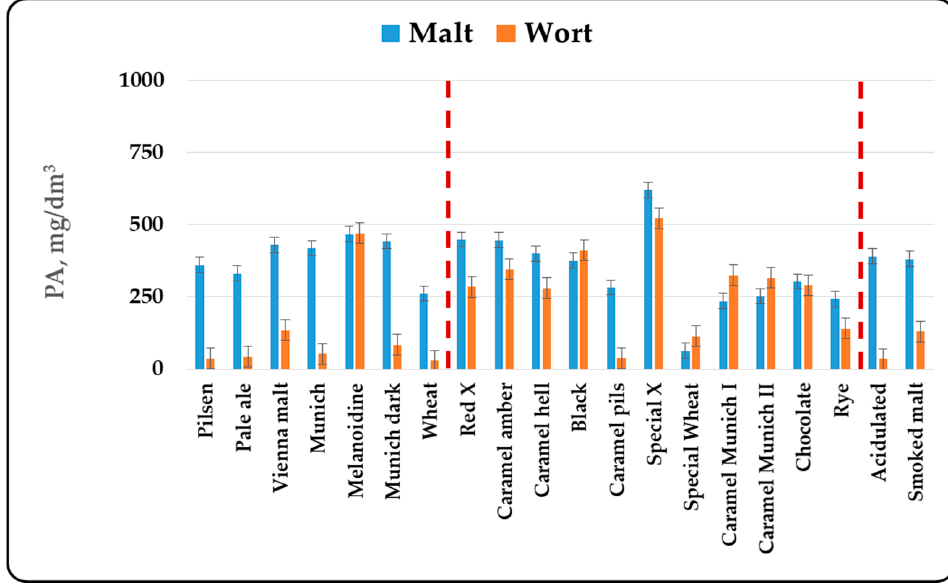
Figure 3. Phenolic acids in different malt types, determined by the direct spectral method.